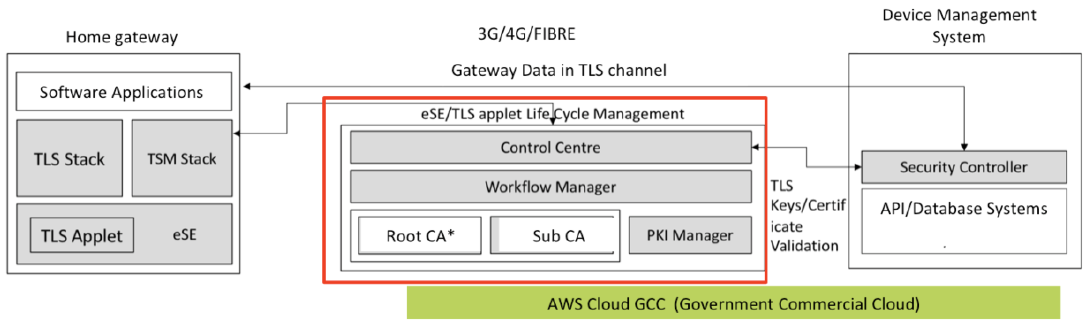
Figure 16. TLS Architecture of the smart DB.